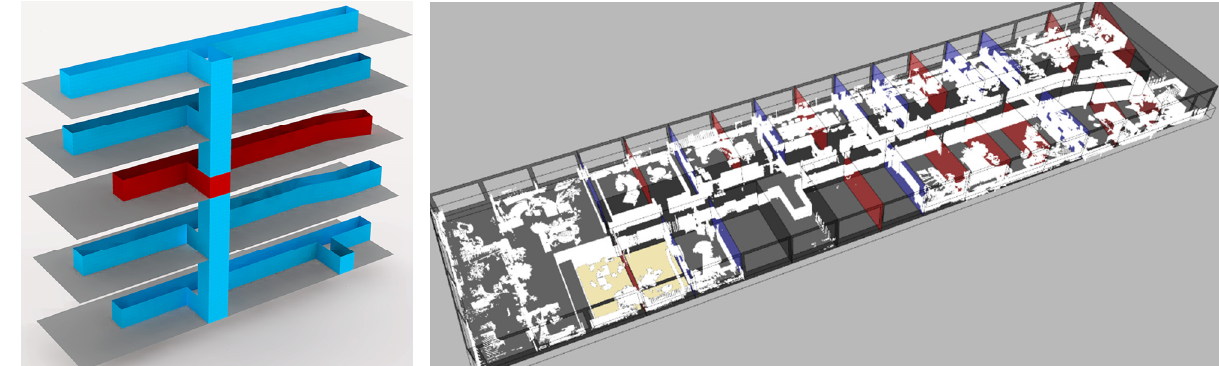
Figure 3. Network of hallways and stair- Figure 4. 3D indoor model for the 4 th floor (here overlaid with the 3D point cloud) as cases produced by the initial L-system. obtained from applying the initial split